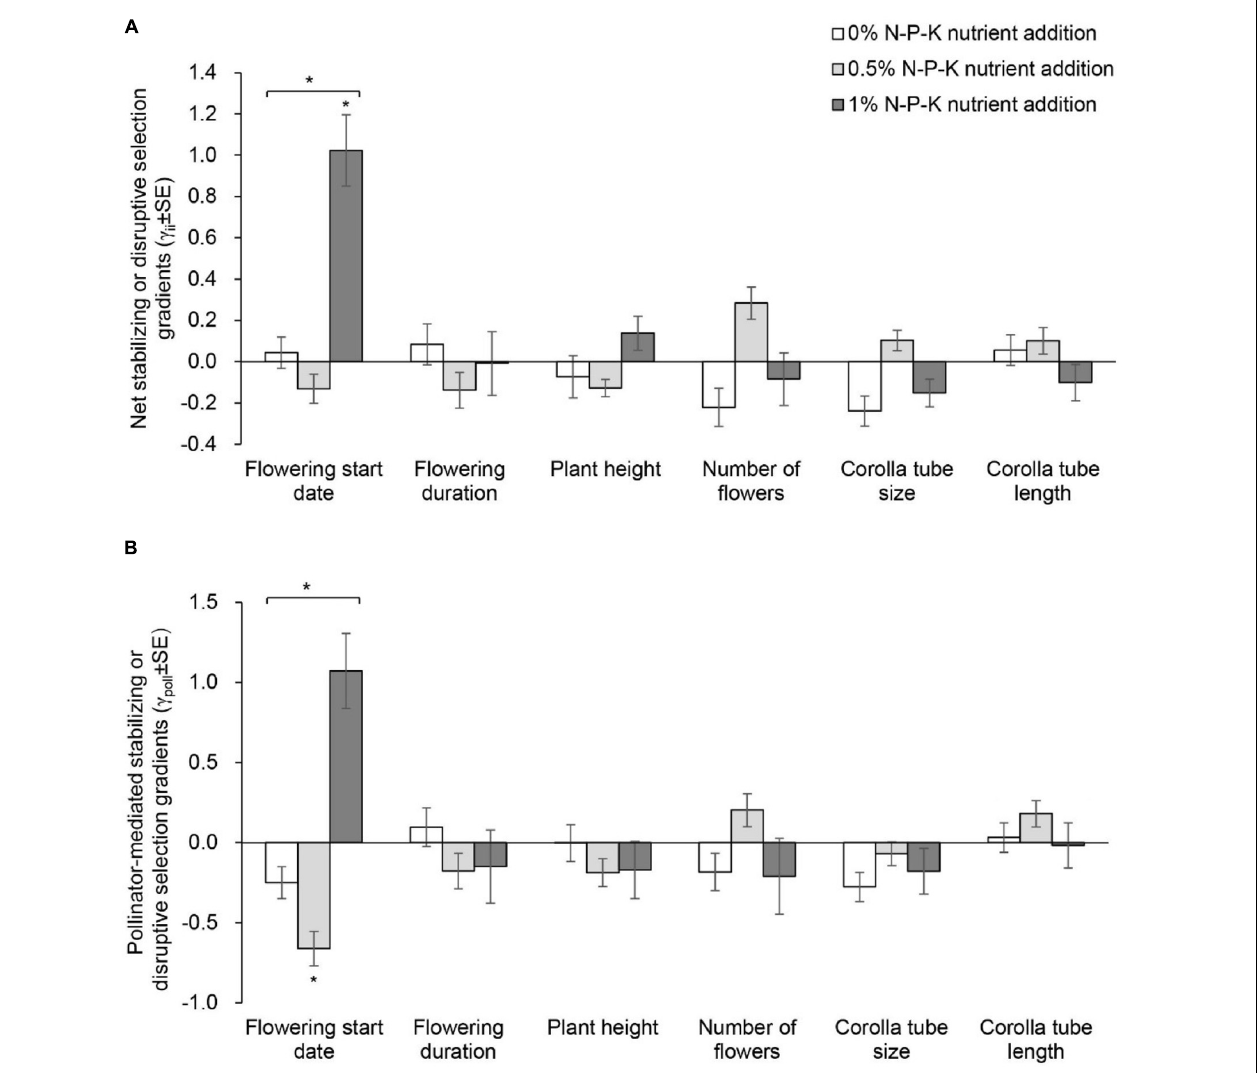
FIGURE 5 | Net stabilizing or disruptive selection gradients (A) and pollinator-mediated selection gradients (B) on flowering start date, flowering duration, plant height, number of flowers, and corolla tube size and length in Primula tibetica among nutrient addition treatments. The symbols above the individual bars indicate the level of significance of the selection gradient. Symbols above the lines spanning several gradients show whether ANCOVA indicated significant variation among nutrient addition treatments in selection gradients. * P <